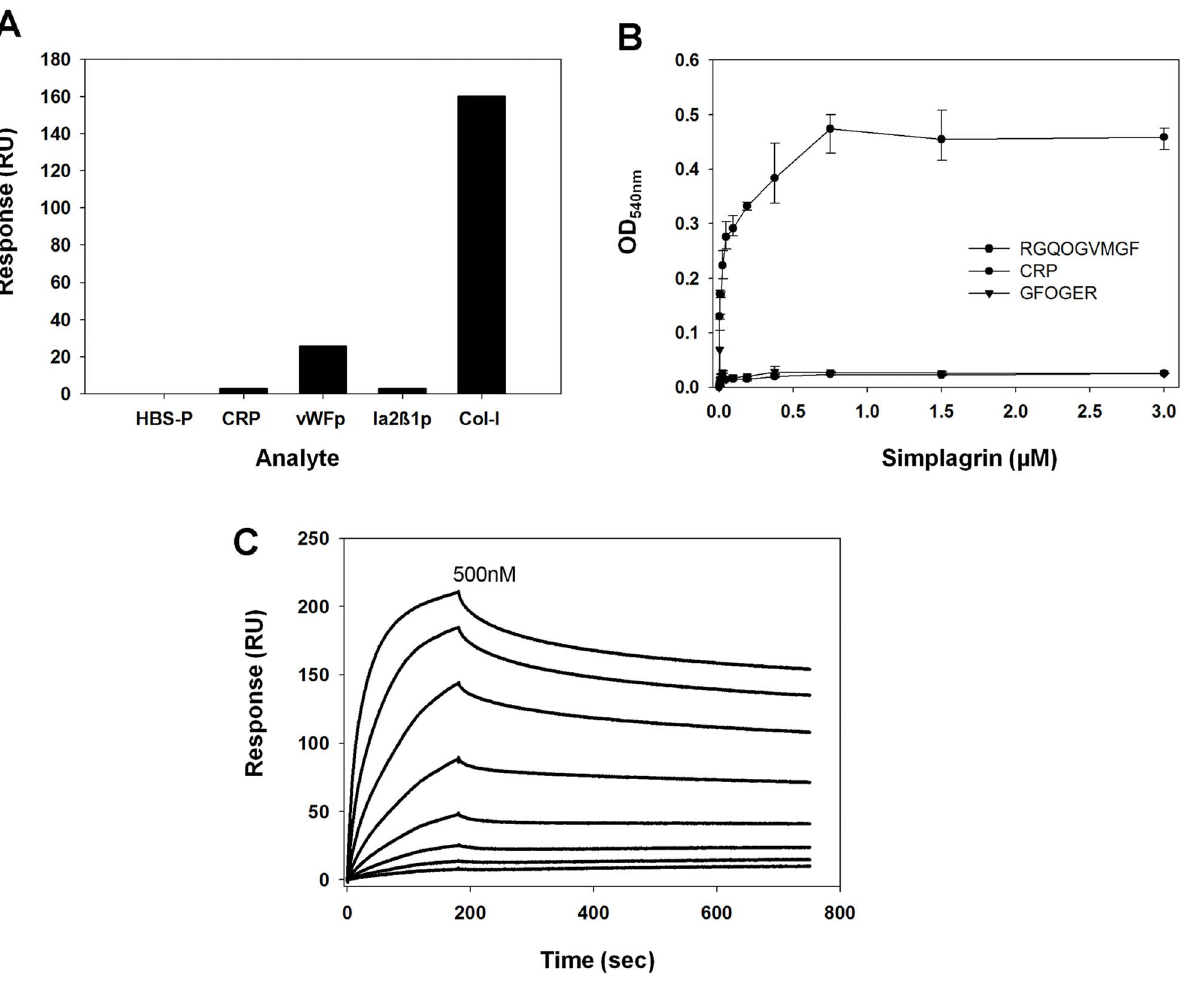
Figure 8. Simplagrin binds to RGQOGVMGF, the von Willebrand Factor (vWF) binding site on collagen. (A) Surface plasmon resonance binding analysis of immobilized Simplagrin with CRP (cross-linked GPO 10 ), vWFpep (cross linked RGQOGVMGF), I a 2 b 1 pep (cross-linked GFOGER) and Col-I (collagen type I). (B) Solid phase binding assay shows that Simplagrin binds in a dose response manner to wells coated with RGQOGVMGF peptides. Binding was detected using rabbit anti-Simplagrin antibodies. (C) Kinetic analysis showing that Simplagrin displays high affinity (K D 11.1 6 0.59 nM) for RGQOGVMGF peptide. Analyte concentration ranging from 1–500 nM of RGQOGVMGF were flowed over immobilized Simplagrin at 30 m L/minute for 180 seconds, and the complex dissociation was monitored for 600 seconds before regeneration of the sensor surface. A global 1:1